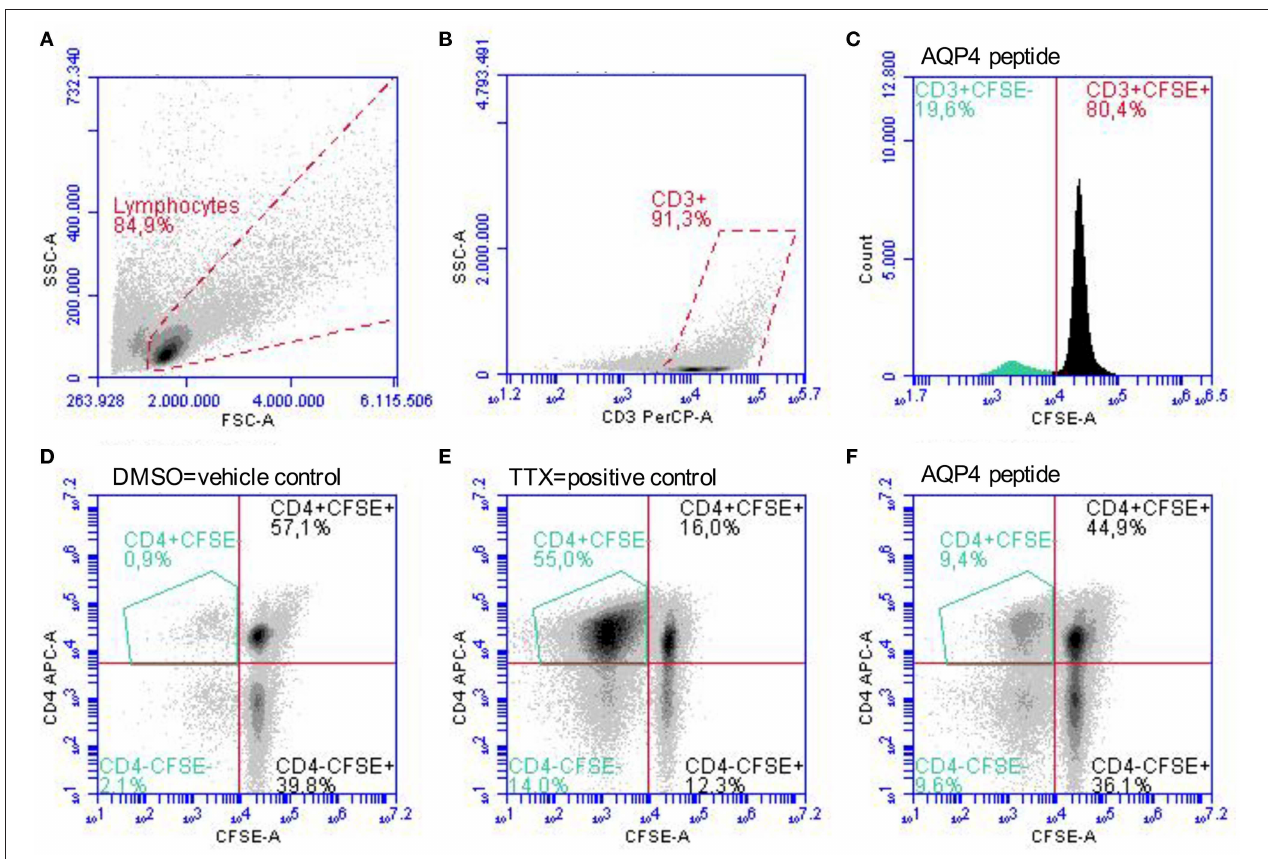
FIGURE 2 | Gating strategy for the identification of proliferated CD4 + CFSE − T-cells. PBMC stimulated with single AQP4 and MOG peptides or the vehicle control DMSO and the positive control TTX were analyzed after 11 days in culture. (A) Gating of lymphocytes according to empirical values of size (FSC) and granularity (SSC) followed by (B) gating of CD3 + T-cells is shown. (C) Dilution of the CFSE staining due to proliferating of CD4 + T-cells in response to an AQP4 peptide. (D–F) Gating of proliferated CD4 + CFSE − T-cells. Representative scatter plots of proliferated CD4 + CFSE − T-cells in response to the vehicle control DMSO (D) , to the positive control TTX (E), and to an AQP4 peptide (F) are depicted. APC, allophycocyanin; AQP4, aquaporin-4; CFSE, carboxyfluorescein succinimidyl ester; DMSO, dimethyl sulfoxide; FSC, forward scatter; MOG, myelin oligodendrocyte glycoprotein; PBMC, peripheral blood mononuclear cells; PerCP, peridinin-chlorophyll-protein; SSC, side scatter; TTX, tetanus